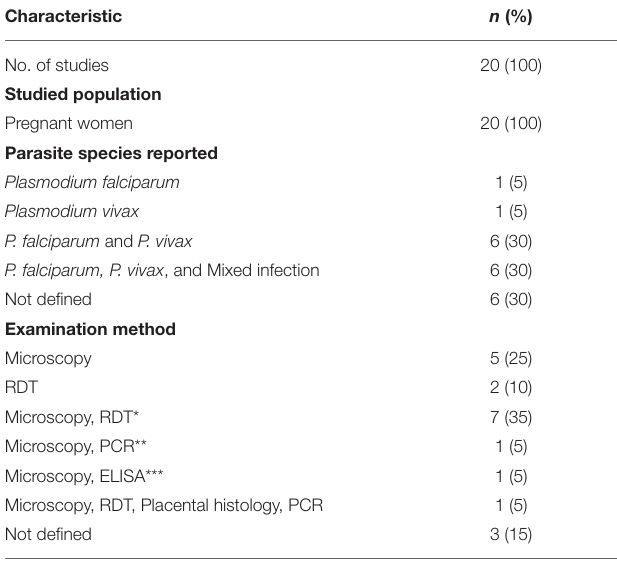
TABLE 1 | Overview of the published reports considered for final